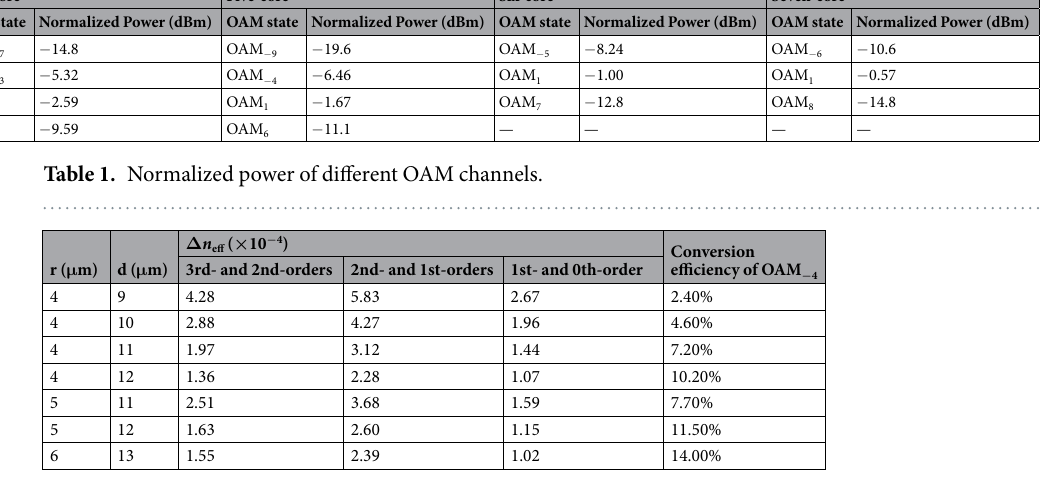
Table 2. Some parameters supporting long distance transmission of the OAM